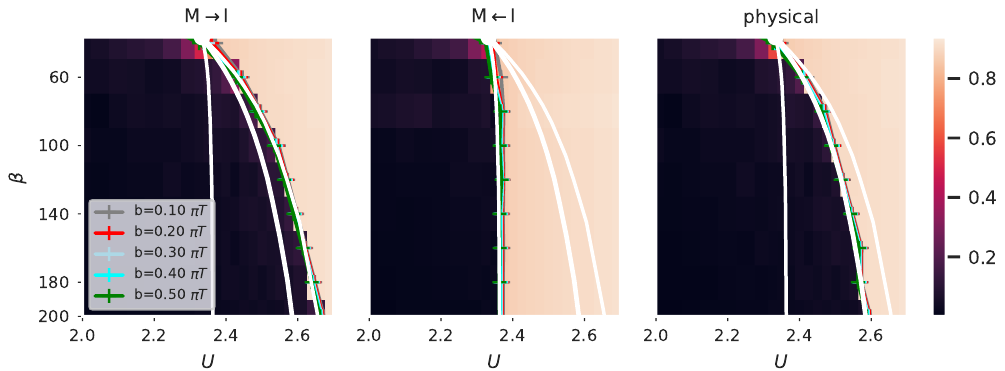
Figure 5: Hysteresis of the double occupancy (left panel, reproduced from Fig. 1) and of the estimated anomalous term in the local spin susceptibility (right) along the chosen U -path at fixed T = 1 / 200 across the coexistence region (grey-shadowed area) of the Mott MIT in the half-filled Hubbard model. The black vertical line at [ 29 ] , which marks the interaction value where the thermodynamic first-order U c MIT takes place, is defined by the equality condition of the free energies of the two phases.